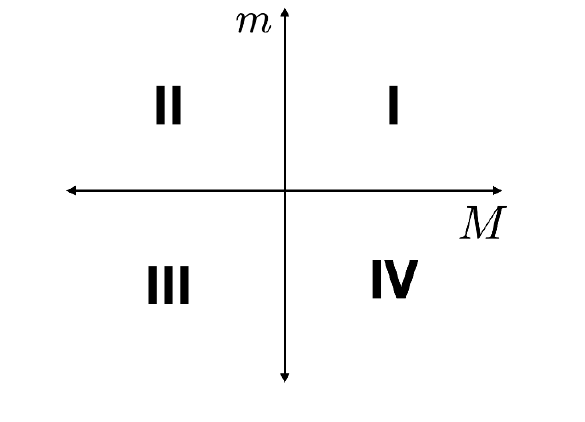
Figure 2 . Phases when f + F < k